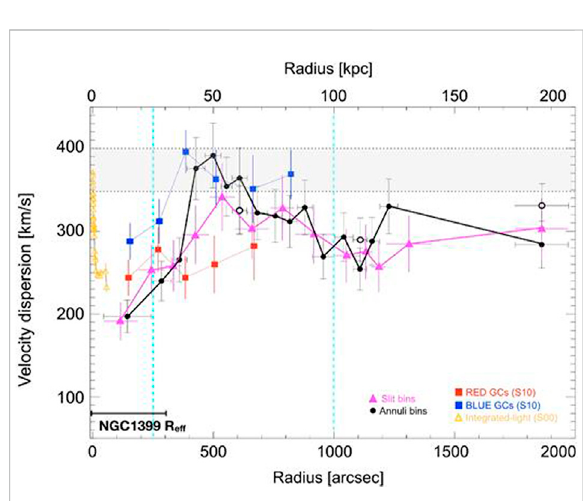
FIGURE 3 Velocity dispersion pro fi le of diffuse light in the Fornax cluster, from the center of NGC 1399 out to 200 kpc. The fi lled black circles. The three σ LOS (R) from PNe is plotted as empty symbols show values at radii where PNe most likely associated with satellite galaxies were removed. σ LOS (R) from red and blue GCs (see Schuberth et al., 2010; S10 in the fi gure) are shown as red and blue squares, respectively. The inner velocity dispersion pro fi le from absorption line spectra (Saglia et al., 2000; S00 in the fi gure) is shown as yellow triangles. The grey shaded horizontal region represents the σ LOS , gal of the Fornax cluster with its 1 σ error. Image reproduced from 8 of Spiniello et al. (2018) with